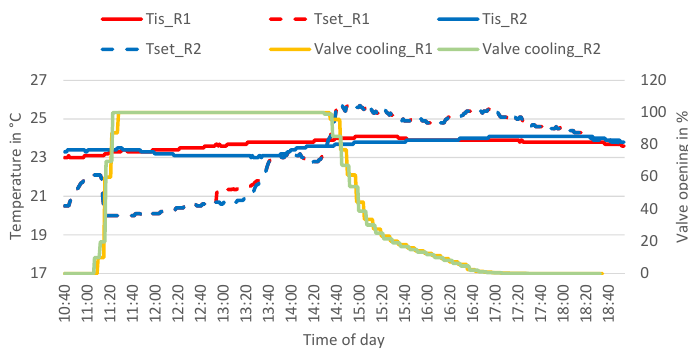
Figure 10. Room and set temperatures and valve openings for two MAS rooms in the field